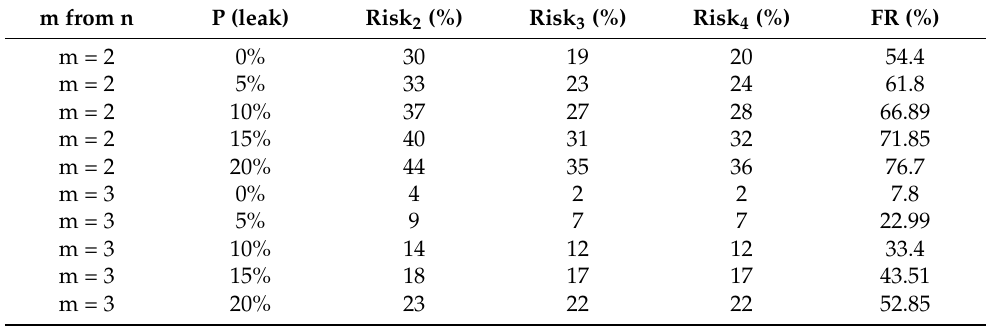
Table 4. The sensitivity analysis of noise parameter and “m from n” structure of start-up Y .